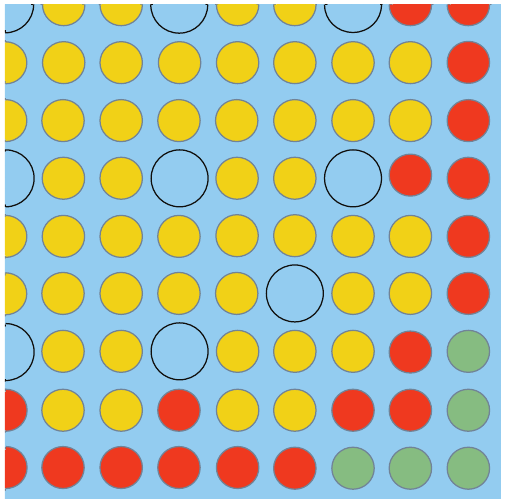
Figure3:TheBA-containingUOXreferencefuelassemblydesign(a quarter of the fuel assembly). Yellow rods consist of 4.4% enriched uranium;redrodsconsistof2.8%enricheduraniumand6% Gd 2 O 3 . The non-BA-containing reference fuel design is identical except that all rods are of the former (yellow) type.